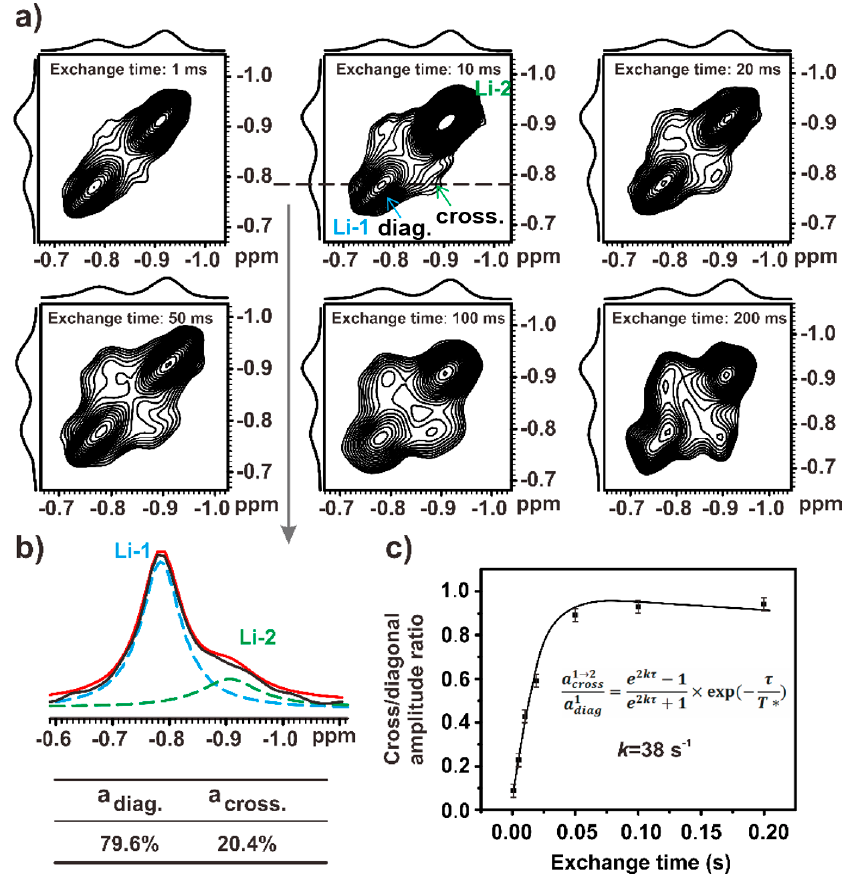
Figure 6. ( a ) The 2D 7 Li– 7 Li exchange spectrum of IM240 ‐ PEO/Li + . This spectrum was acquired using an exchange time of 1 to 200 ms at 305 K. ( b ) The cross ‐ section spectrum extracted at δ = − 0.78 ppm an exchange time of 1 to 200 ms at 305 K. ( b ) The cross-section spectrum extracted at δ = − 0.78 ppm from 2D exchange 7 Li– 7 Li spectra of IM240 ‐ PEO/Li + with an exchange time of 10 ms (black line). The from 2D exchange 7 Li– 7 Li spectra of IM240-PEO / Li + with an exchange time of 10 ms (black line). blue and green dotted lines denoted the fitting peaks of Li ‐ 1 and Li ‐ 2, respectively. The red line The blue and green dotted lines denoted the fitting peaks of Li-1 and Li-2, respectively. The red line denoted the fitting cross ‐ section spectrum. ( c ) The fitting curve between the ratio of the cross/diagonal denoted the fitting cross-section spectrum. ( c ) The fitting curve between the ratio of the cross / diagonal peak and exchange time. peak and exchange